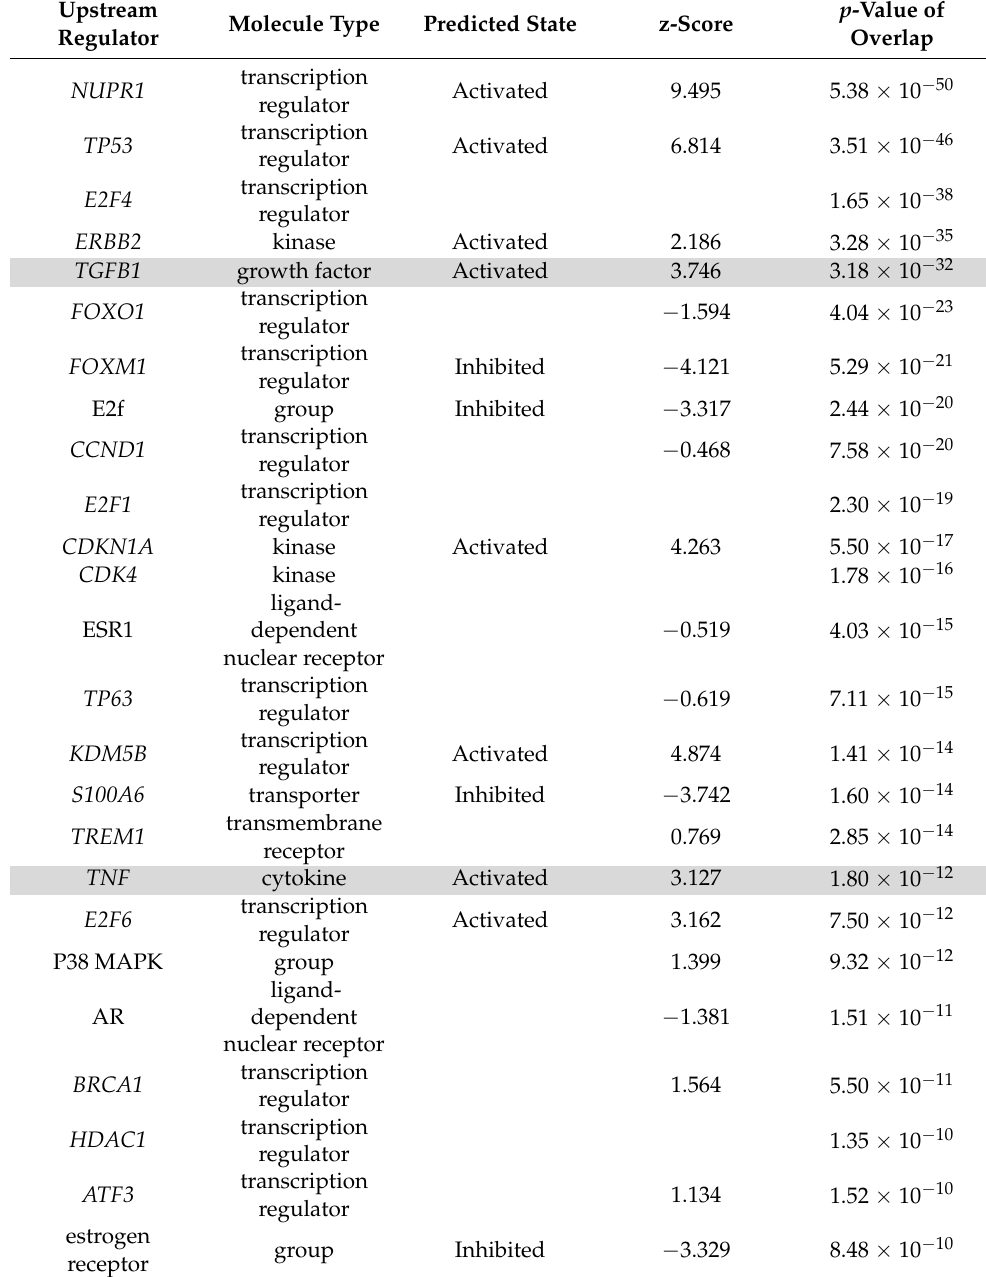
Table 1. Predicted upstream regulators in A549 cells treated with cigarette smoke